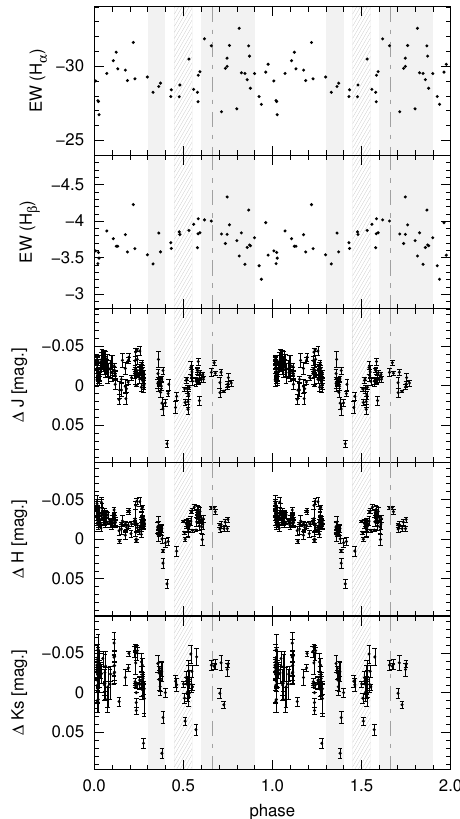
Figure 6. Relative magnitude in the near-infrared band of HESS J0632 + 057 (IRSF/SIRUIS), compared with EW of H α and H β [17,19]. From the top to bottom, EW(H α ), EW(H β ), J , H , and Ks magnitude are plotted. The orbital period (313 days) to fold the data, and the phase at periastron ( φ periastron = 0.663) are cited from Moritani et al. [17]. See Figure 5 for the description of the gray and striped